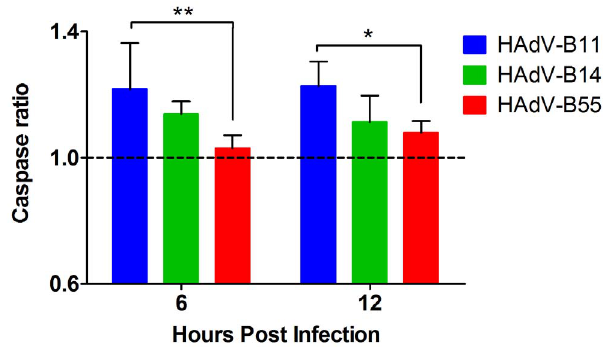
Figure 4. Levels of apoptosis in HAdV-B55-, HAdV-B14- or HAdV-B11-infected A549 cells. A549 cells were infected with HAdV- B11, HAdV-B14 or HAdV-B55 at an MOI of 10. At 12, 24 and 48 h post- infection, the results were assessed using the ApoTox-Glo Triplex Assay (Promega) according to the manufacturer’s instructions. The values of the caspase ratio (infected to uninfected) are shown as the mean 6 standard deviation of four replicates from two independent experi- ments. Statistical significance was determined using a two-way ANOVA